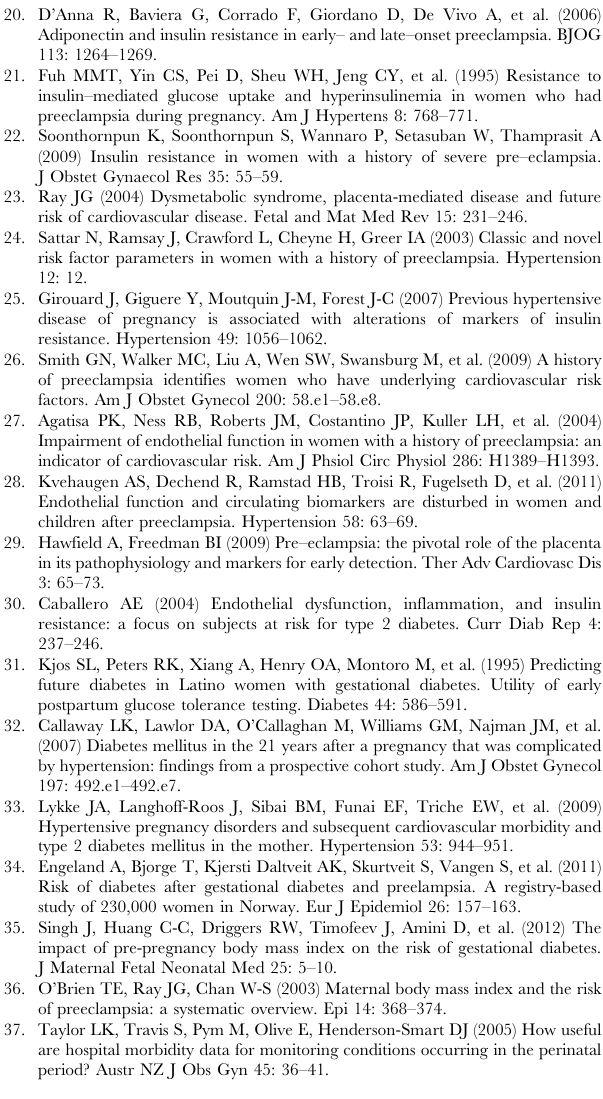
Table S2 Number of women at risk at the end of each follow-up year in Ontario, from 1994 to 2011. *Year 0 indicates the beginning of the follow-up